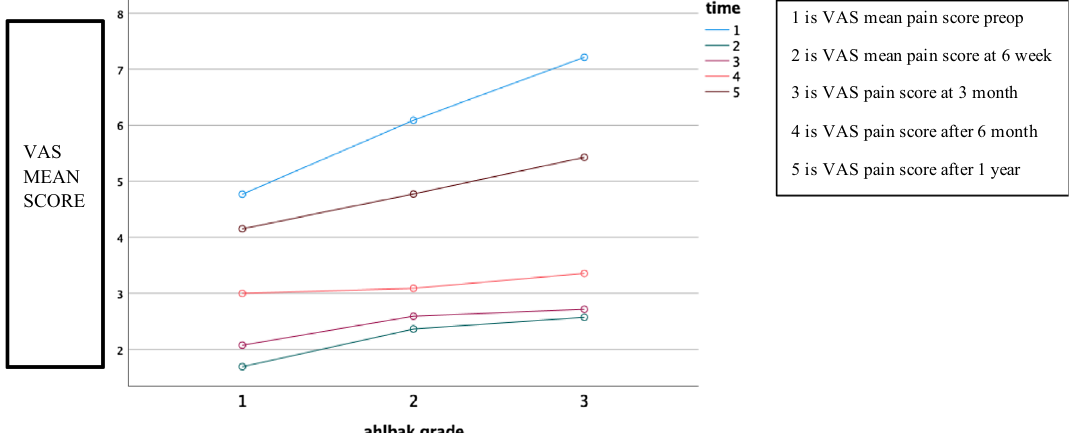
Figure 2. Effect of knee degeneration grade on VAS. The overall best improvement after 6 months and 1 year was observed in Ahlbäck I sub- group and the overall least improvement in Ahlbäck III sub-group. This shows a statistically signi fi cant improvement ( p < 0.05) in all sub- groups after PRP